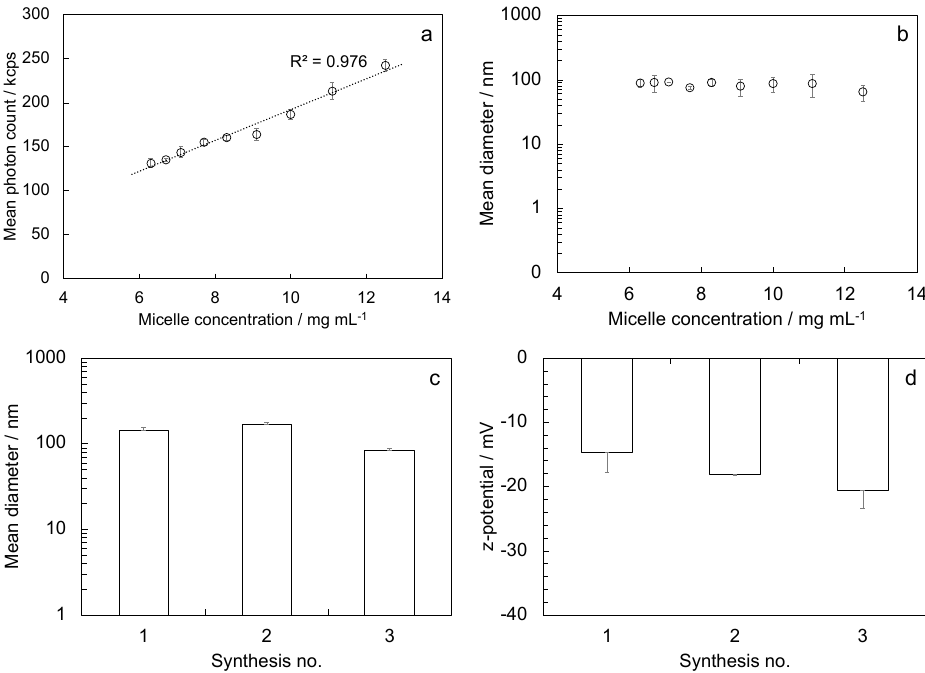
Figure 4. Characterization of stabilized reversed micelles: ( a ) mean photon count and ( b ) mean diameter calculated in dilution tests; ( c ) mean diameter and ( d ) z-potential evaluated in three repeated syntheses.